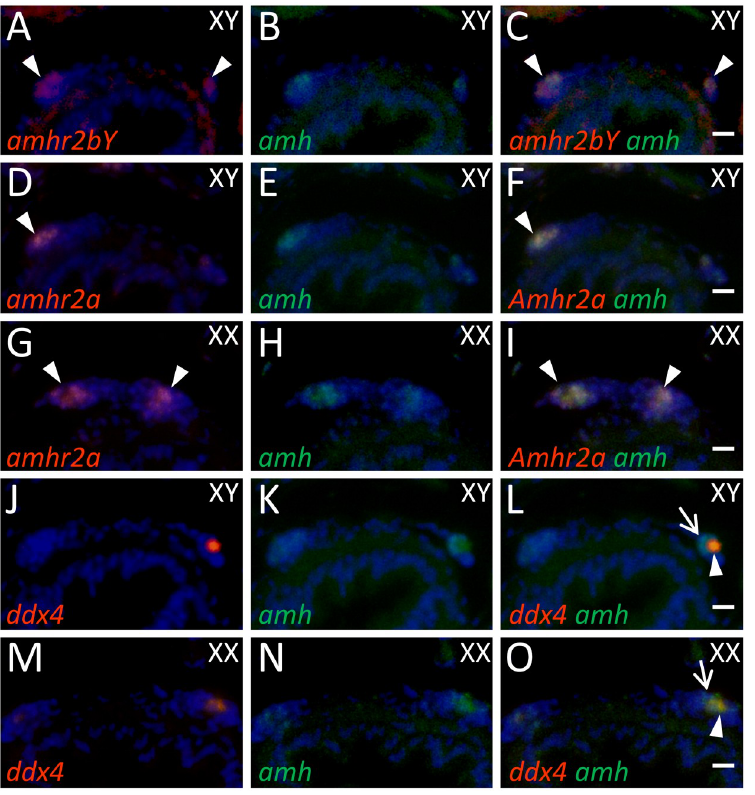
Fig 7. Expression of amhr2s and amh (encoding putative ligand of Amhr2 ) in morphologically undifferentiated gonads. (A–C) Two-color section in situ hybridization showing amhr2bY (A, red) and amh (B, green) transcripts in XY gonads at 2 months post fertilization (mpf). (D–I) Two-color section in situ hybridization showing amhr2a (D and G, red) and amh (E and H, green) transcripts in XY (D–F) and XX (G–I) gonads at 2 mpf. (J–O) Two-color section in situ hybridization showing germ cell marker ddx4 (J and M, red) and amh (K and N, green) transcripts in XY (J–L) and XX (M–O) gonads at 2 mpf. Panels show that both amhr2 and amh co-localize in somatic cells in morphologically undifferentiated gonads. amh transcripts are also present in ddx4 -positive germ cells. Arrowheads in A–I indicate amhr2bY - and autosomal amhr2a -positive signals. Arrowheads in L and O indicate germ cells co-expressing amh and ddx4 . Arrows in L and O indicate amh -positive somatic cells. Scale bar: 10 μ m.